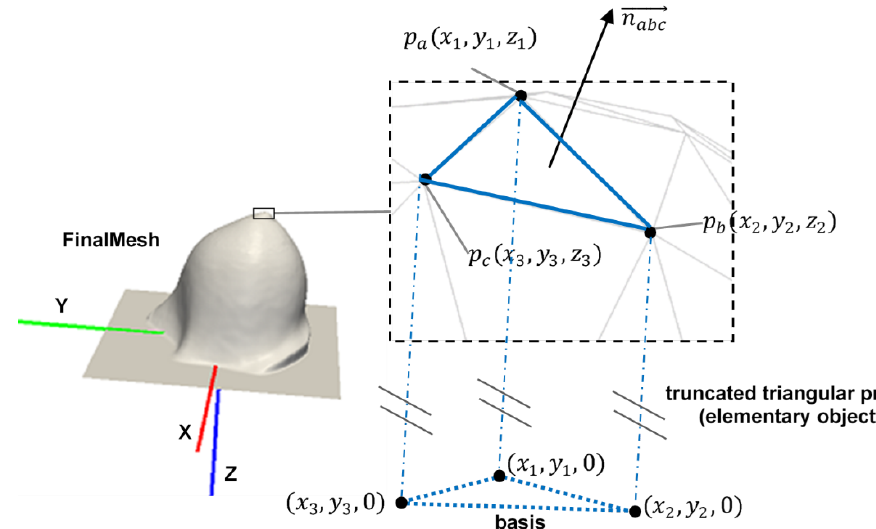
Figure 26. 3D mesh volume computation by using a truncated triangular prism as elementary object.